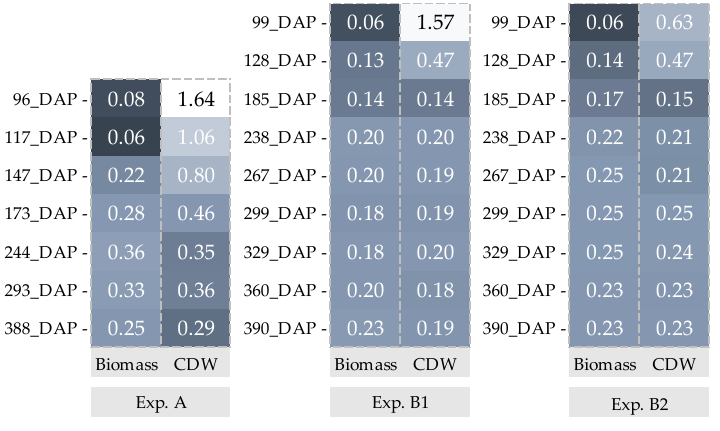
Figure 4. Heat maps of σ 2 values of the emulators built for biomass and CDW at each reporting frequency of three experiments: Experiment A, Experiment B1 and Experiment B2. Color ranges from dark blue to white represent values from 0 to higher values.